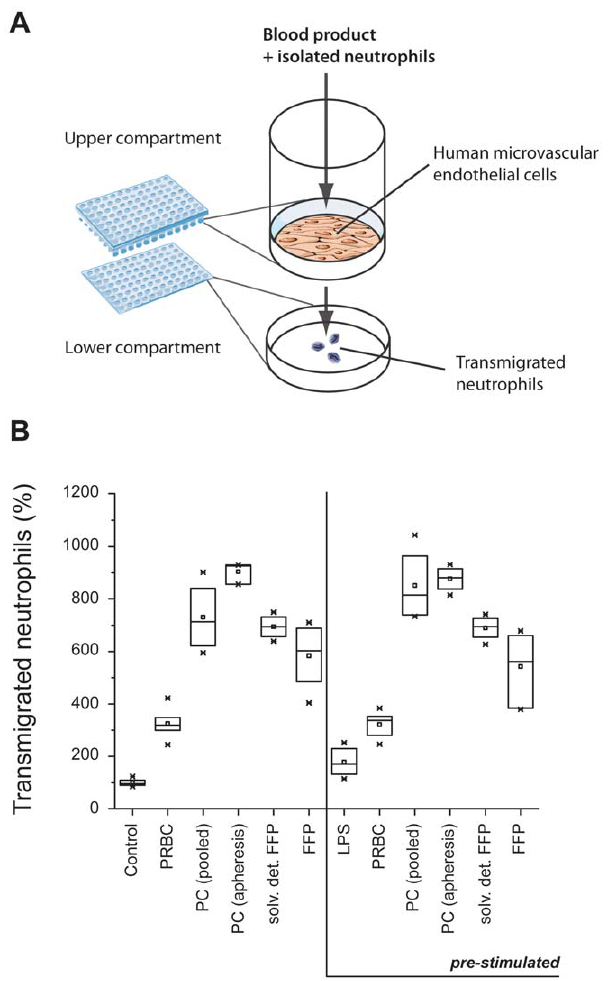
Figure 2. Neutrophil transmigration through an endothelial cell layer after exposure to blood products. Transmigration of neutrophils through unstimulated and pre-stimulated monolayer of human microvascular endothelial cells (HMVEC) (A). HMVEC were stimulated with lipopolysaccharide (LPS) 2 m g/ml for 6 h (pre-stimulat- ed) or not (unstimulated), followed by a 2 h-incubation with the according supernatant of previously centrifuged blood products such as packed red blood cells (PRBC), platelet concentrates (PC), pooled or apheretic, and solvent detergent or untreated fresh frozen plasma (FFP) together with 1.5 6 10 6 neutrophils. Transmigrated neutrophils were measured using a glucuronidase assay (B). Results are shown as medians with interquartile ranges.